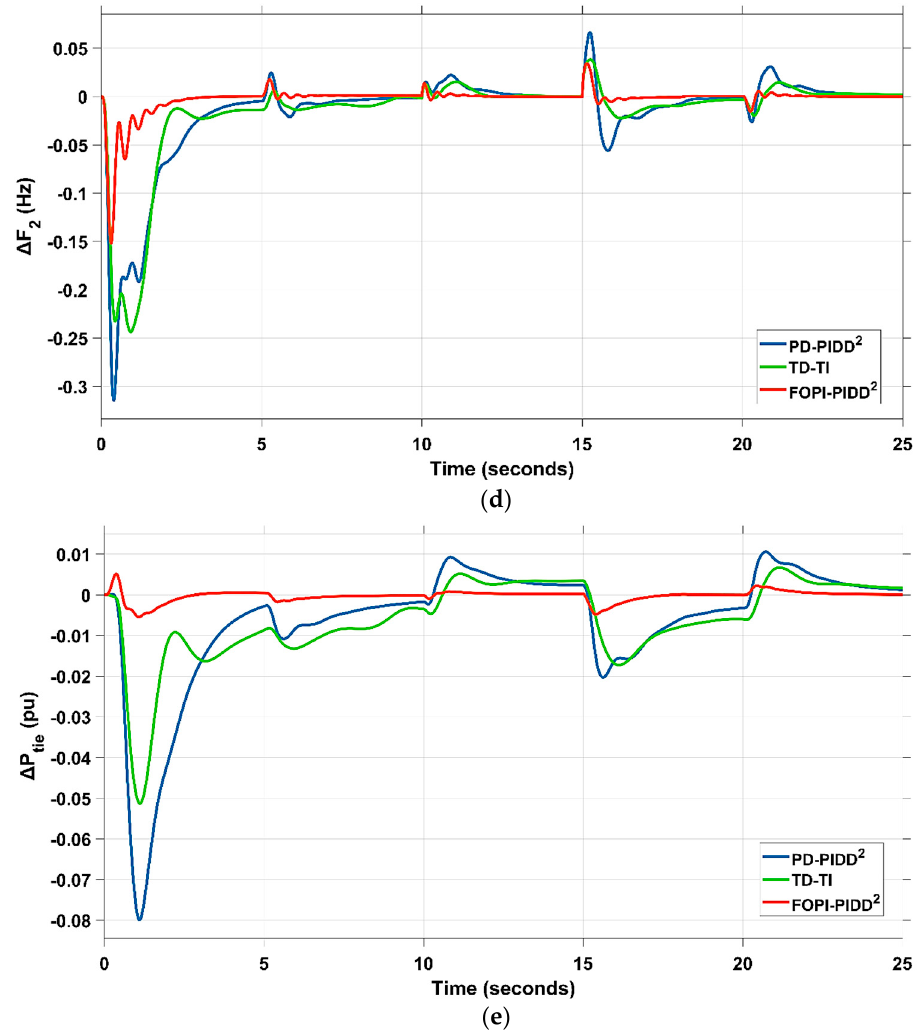
Figure 24. Comparison of PD–PIDD 2 , TD–TI, and FOPI–PIDD 2 optimized by DO algorithm for scenario 2: ( a ) V 1 , ( b ) V 2 , ( c ) ∆ F 1 , ( d ) ∆ F 2 , and ( e ) ∆ P tie .